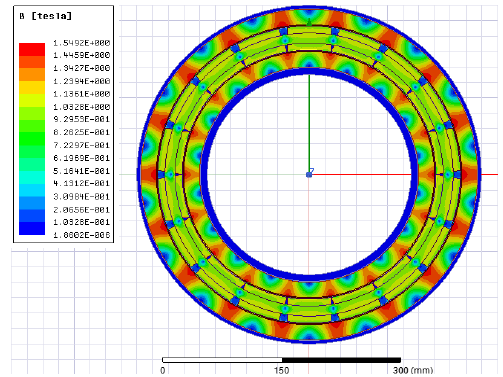
Figure 11. Cloud diagram of magnetic density.